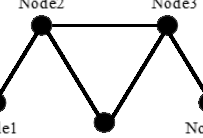
Figure 6. Comparison of converging speed of different methods: ( a ) uniform; ( b ) metropolis.